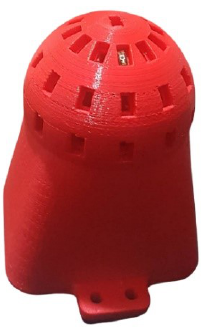
Figure 4. 3D Printed body.